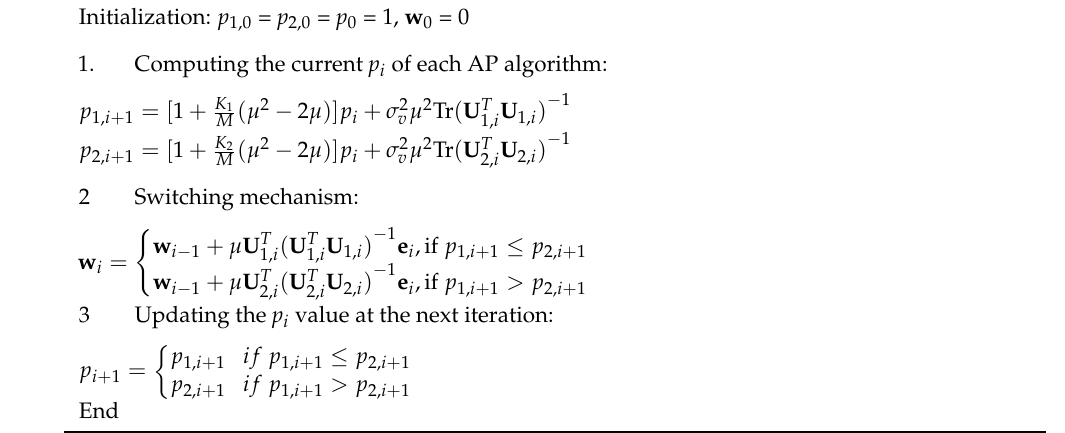
Table 1. The proposed algorithm.